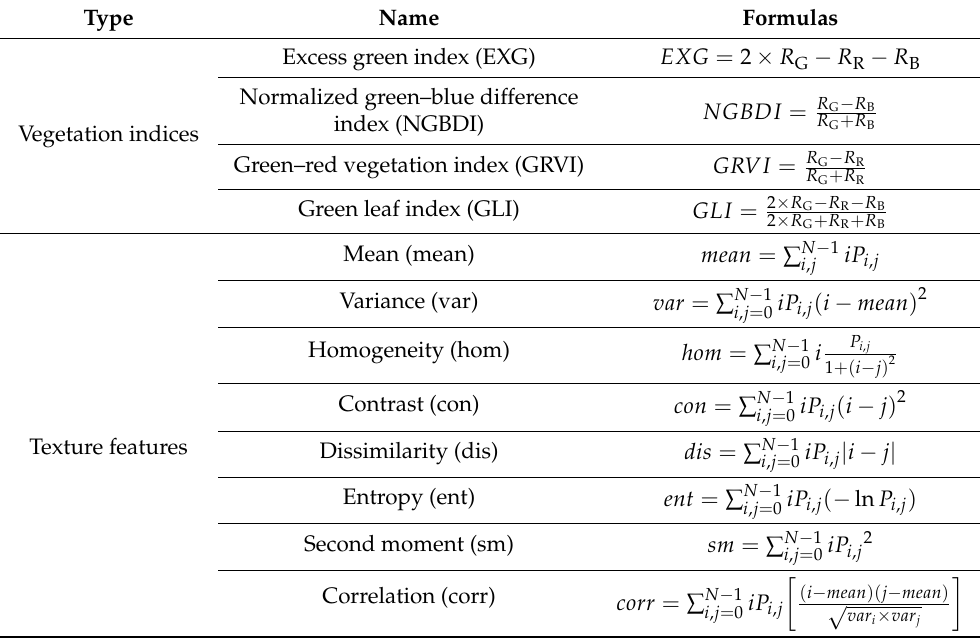
Table 1. Vegetation index and texture feature calculation